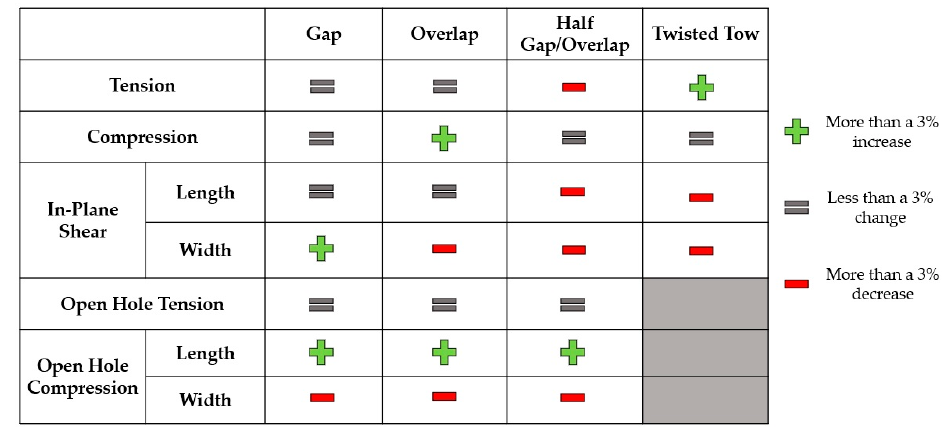
Figure 2. Effects of defects encountered during the AFP process.